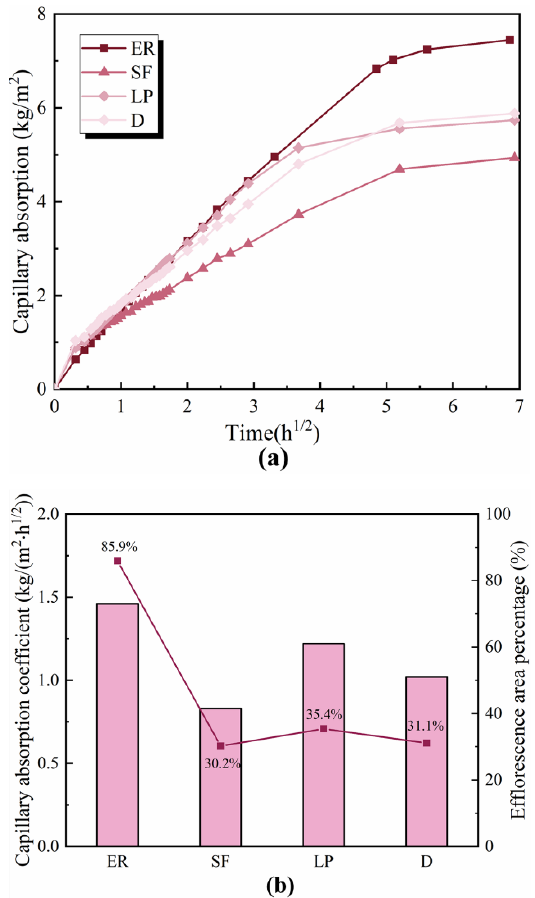
Figure 7. Capillary absorption ( a ) and capillary absorption coefficient ( b ) of cement mortars.